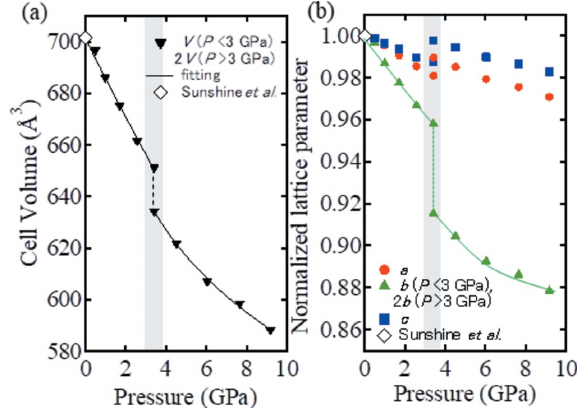
Figure 2 Pressure dependence of ( a ) the cell volume at room temperature and ( b ) the lattice parameters, normalized using the corresponding ambient lattice parameters (Sunshine & Ibers, 1985). Note that the b axis and cell volume are multiplied by 2 in the high-pressure phase region. Low- and high-pressure structures coexist within the shaded area at (cid:2) 3 GPa. The solid lines shown in panels ( a ) and ( b ) represent data fitting with respect to the equation of state and a guide for the eye,